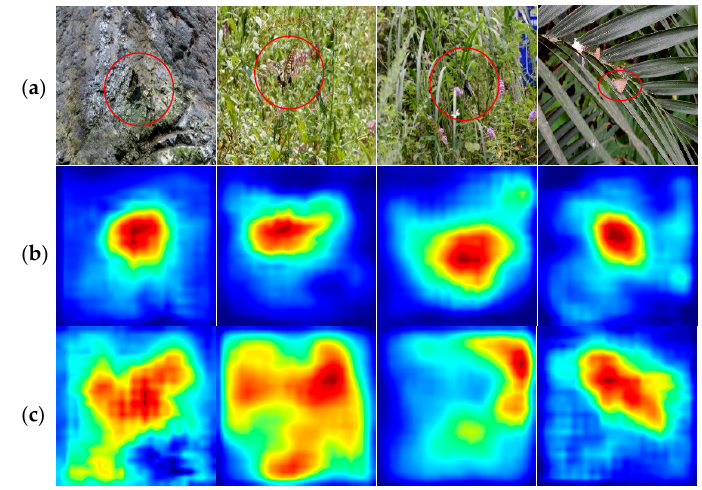
Figure 9. ( a ) Butterfly sample images, ( b ) Grad-CAM obtained by the proposed SESADRN model, ( c ) Grad-CAM obtained by the existing state-of-the-art model (DADRN) [32].